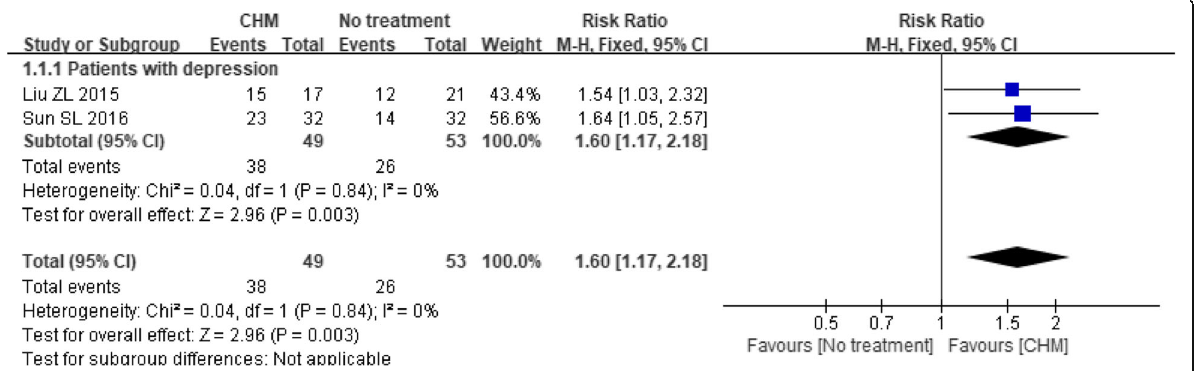
Fig. 13 Forest plot of the treatment response rate of quality of life for CHM versus no treatment